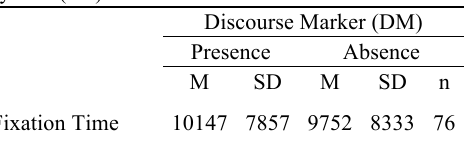
Table 6. Mean and Standard Deviation for Fixation Time, First Pass, and Second Pass on the graph system